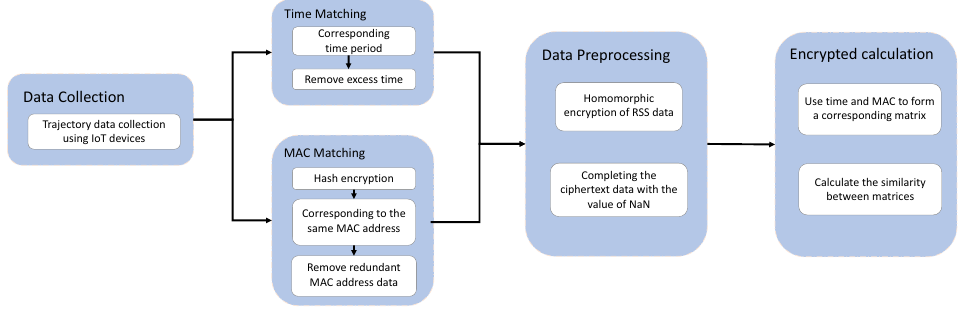
Figure 1. Overall flow chart of the study.